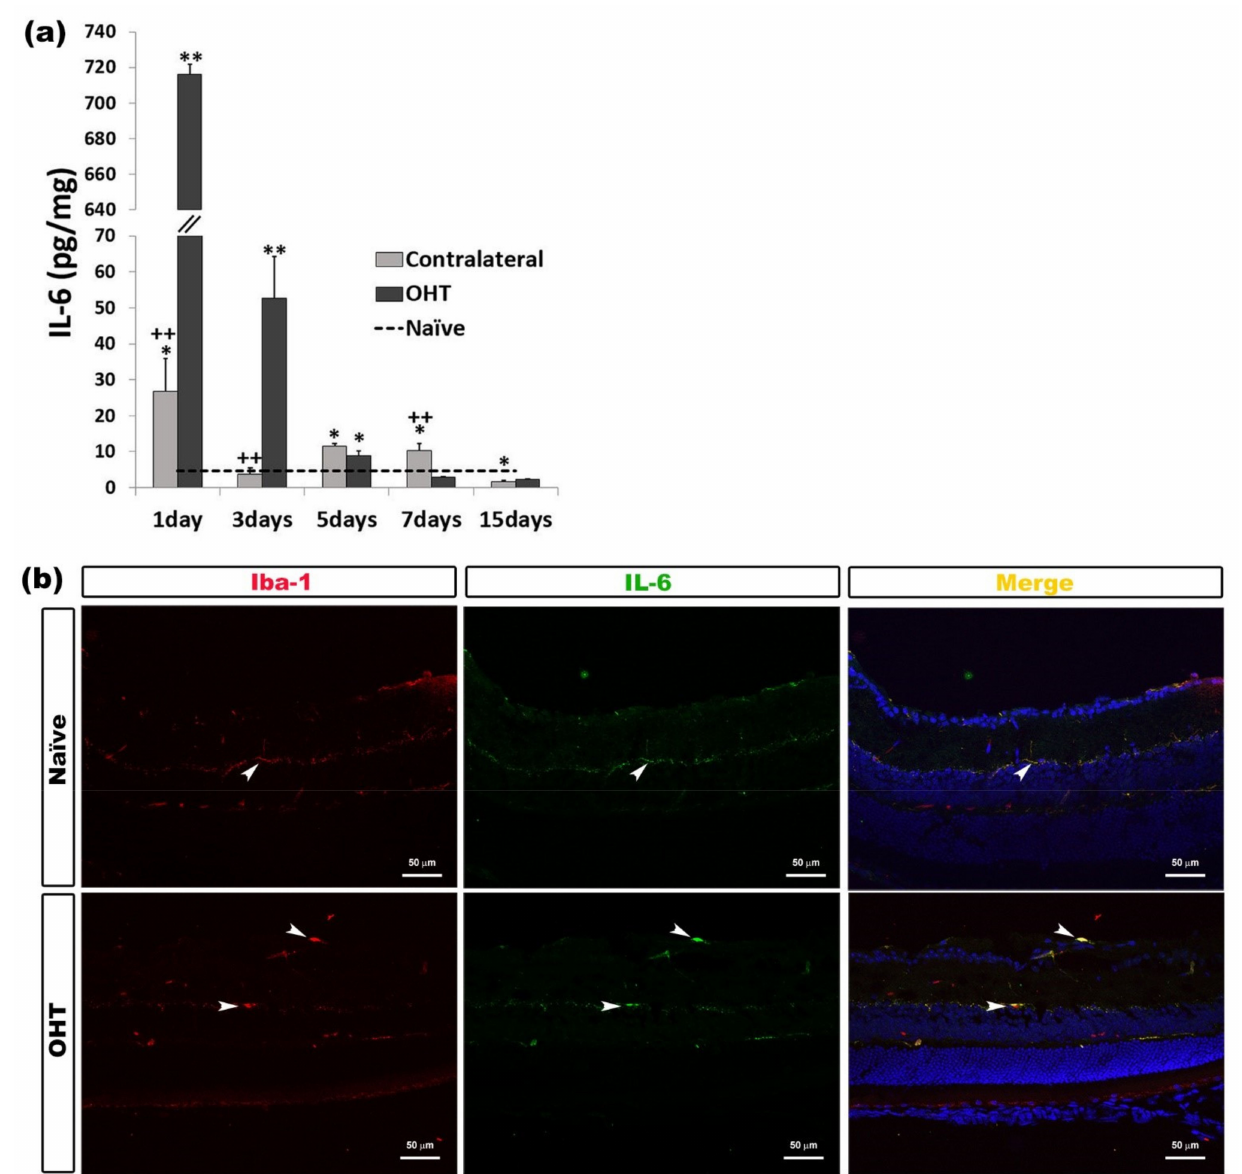
Figure 3. IL-6 levels at different times after laser-induced ocular hypertension (OHT). ( a ) The variation over time in the IL-6 levels in the multiplex assay. The histogram shows the mean levels ( ± SD) of IL-6 (pg/mg) at days 1, 3, 5, 7, and 15 after laser OHT induction, in ocular hypertension eyes (OHT) and in contralateral eyes. The dashed line indicates the mean levels in naïve eyes. Statistical significance indicators: * p < 0.05, ** p < 0.01 vs. naïve; ++ p < 0.01 vs. OHT. ( b ) Immunohistochemical study of IL-6 expression in OHT eyes one day after unilateral laser-induced OHT. Retinal sections were immunolabeled with antibodies to IL-6 (green) and Iba-1 (red). Merge (yellow). The arrowheads show the co-expression of Iba-1 and IL-6 in OHT and naïve eyes. This expression is higher in OHT eyes than in naïve eyes. Abbreviations: OHT (ocular hypertension); IL-6 (interleukin 6); Iba-1 (ionized calcium-binding adaptor molecule 1). Values at different times after laser-induced ocular hypertension (OHT). Variation over time in intraocular pressure IOP values after OHT induction. IL-1 β levels at different times after laser-induced ocular hypertension